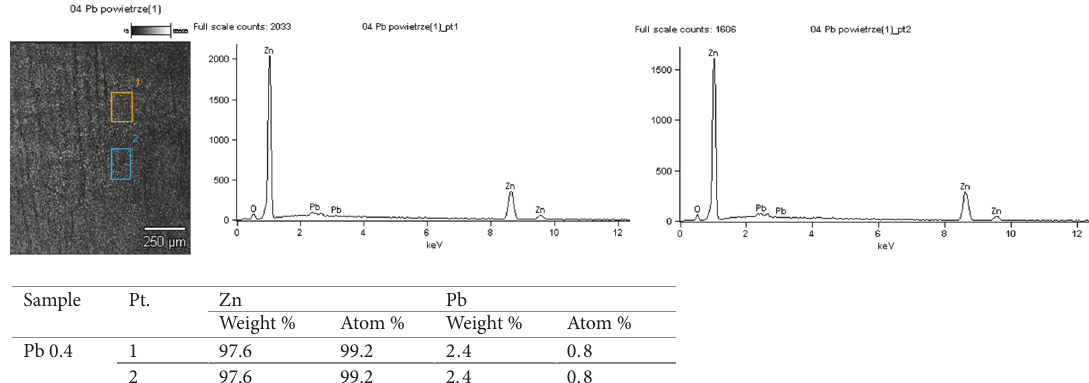
Figure 7: EDS analysis of Pb 0.4/air